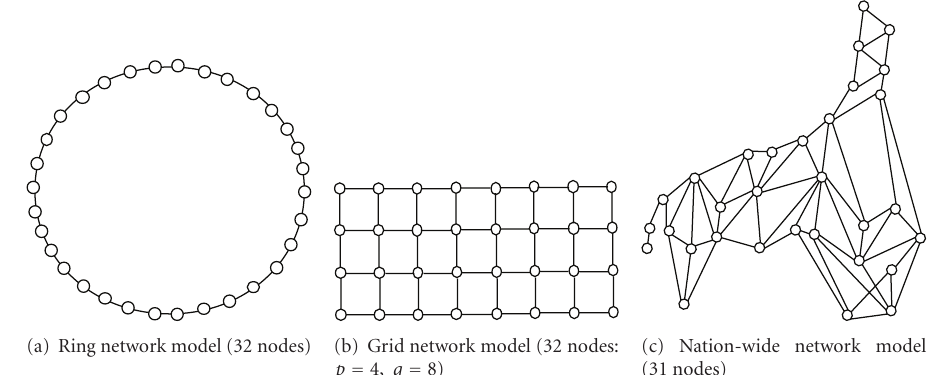
Figure 9: Network model topology.